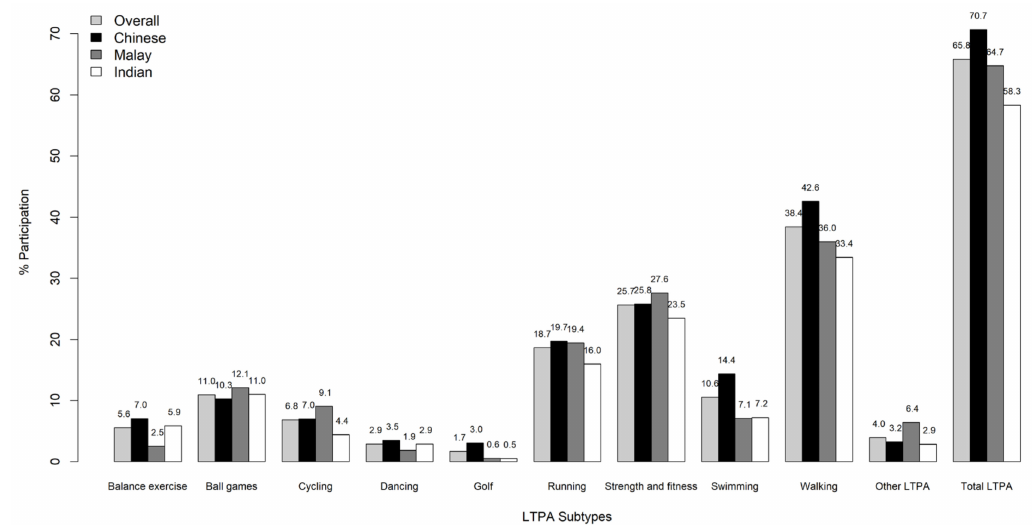
Figure 2. Proportion of participation in various leisure time physical activities across di ff erent ethnic